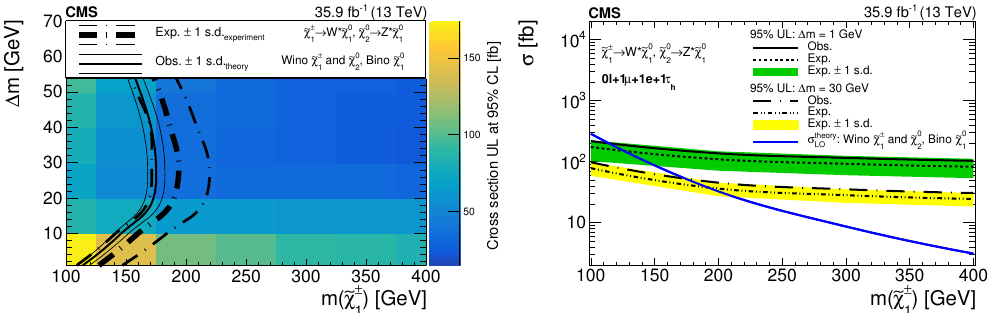
Figure 6 . (Left) Expected and observed 95% con(cid:12)dence level upper limit (UL) on the signal cross section as a function of m ( (cid:31) (cid:6) ) and (cid:1) m , assuming the (cid:31) (cid:6) and (cid:31) 0 decays proceed via W (cid:3) and Z (cid:3) . e e e 1 1 2 The lower left edge of each bin represents the f m ( (cid:31) (cid:6) ) ; (cid:1) m g combination used to calculate the UL e 1 on the signal cross section. For example, the lowest and leftmost bin corresponds to the UL on the signal cross section for the scenario with m ( (cid:31) (cid:6) ) = 100 GeV and (cid:1) m = 1 GeV. (Right) The 95% CL e 1 UL on the cross section as a function of m = m , for (cid:1) m = 1 GeV and (cid:1) m = 30 GeV mass gaps (cid:6) 0 2 e (cid:31) 1 e (cid:31) between the chargino and the neutralino, after combining 0 lepton and 1 lepton channels, assuming the (cid:31) (cid:6) and (cid:31) 0 decays proceed via W (cid:3) and Z (cid:3) e e 1 2